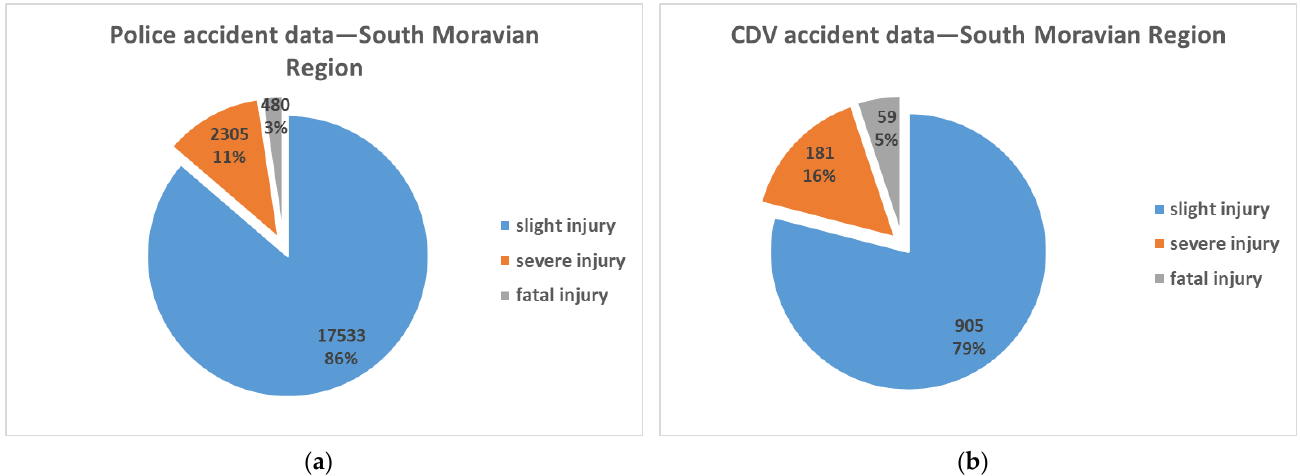
Figure 3. Comparison of police ( a ) and CDV data ( b ) on the time of day when accidents took place in the South Moravian Region (2011–2019).